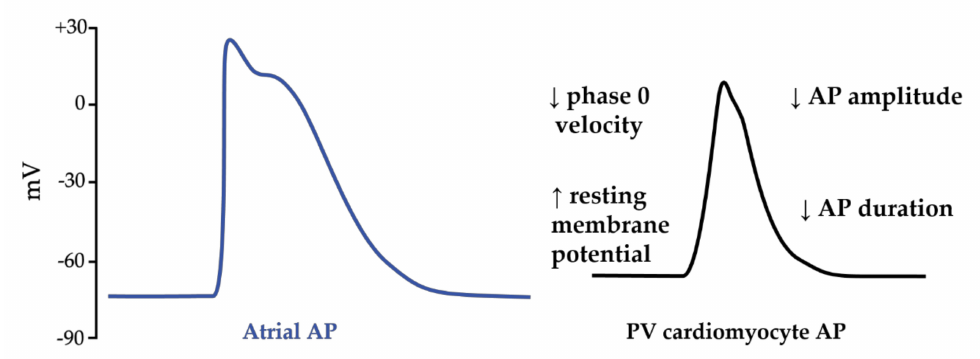
Figure 5. Schematic illustration of differences between action potentials (APs) in atrial cardiomyocytes and in pulmonary vein (PV) cardiomyocytes. Action potential of PV cardiomyocytes have a more depolarized resting membrane potential, a lower AP amplitude, a smaller maximum phase 0 upstroke velocity and a shorter action potential duration compared to atrial